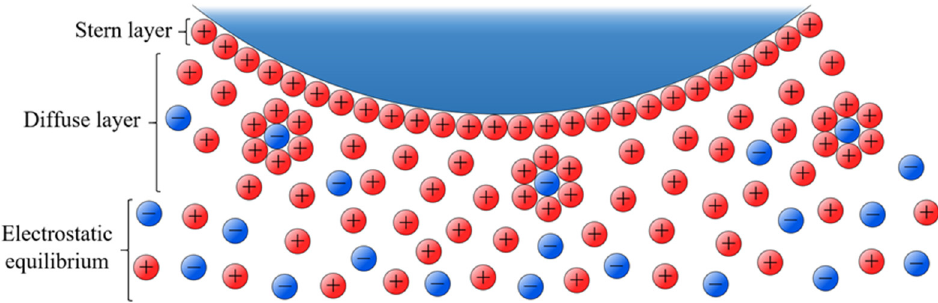
Figure 1. Schematic representation of the electrical double layer in a negatively charged NP.